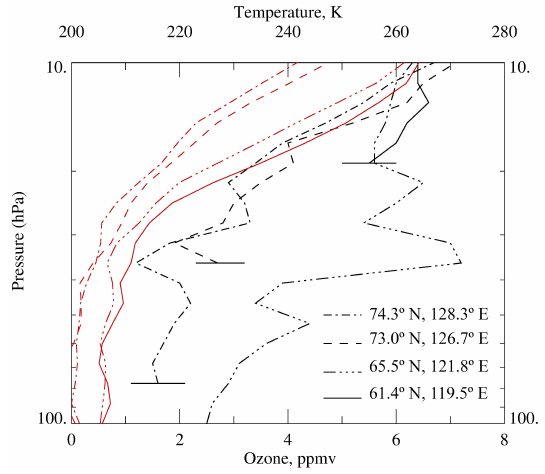
Figure 7. (in black) Four ozone profile segments along an orbital tangent path from 61.4 to 74.3 ◦ N and 119.5 to 128.3 ◦ E on 22 Jan- uary 1979 and where short horizontal lines denote the lower altitude limit of good data; (in red) temperature profiles co-located with the ozone.